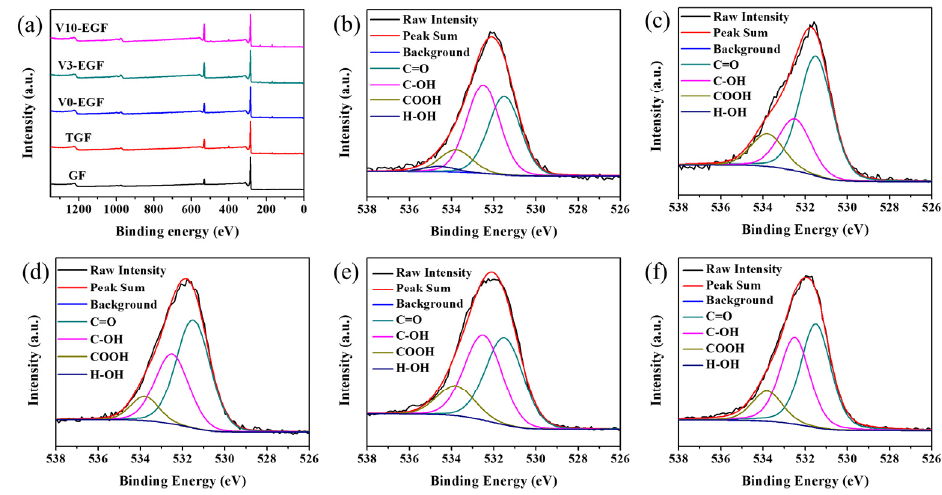
Figure 4. ( a ) XPS survey spectra, and O1s core-level spectra of ( b ) GF, ( c ) TGF, ( d ) V0-EGF, ( e ) V3-EGF, and ( f ) V10-EGF. Table 1. XPS O1s spectra fitting results from Figure 4.